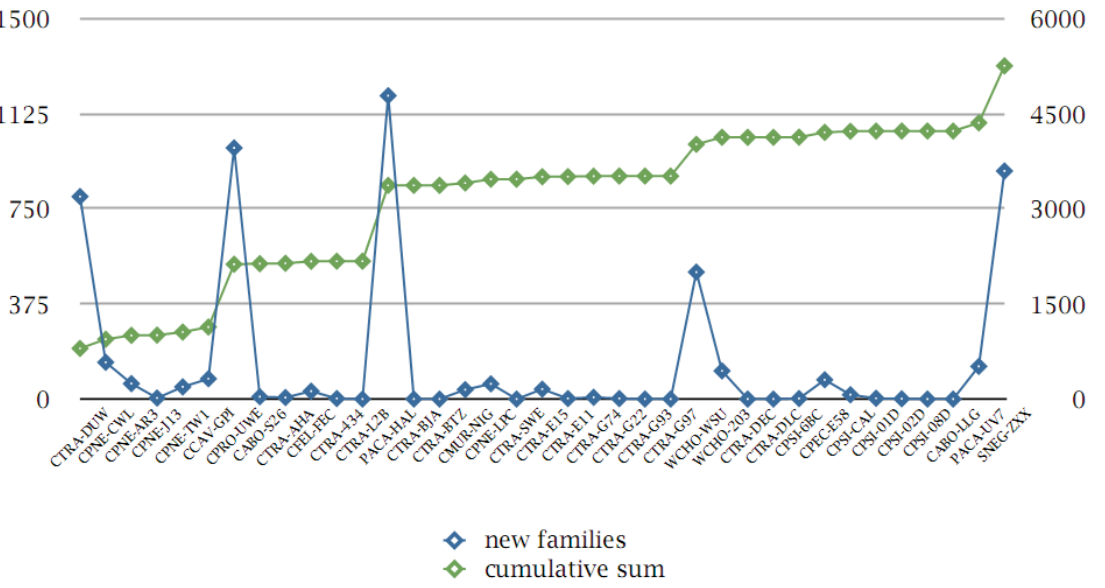
Figure 6. Protein family contributions from genome projects. Genome codes are sorted according to their original publication date (and/or release date, x-axis); absolute number of “novel” protein families within the pangenome are given (left y-axis, blue curve and square symbols); cumulative sum of protein families (up to 5,260, excluding those without self-hits, see text) is also shown, defined as a “pangenome saturation curve” (right y-axis, green curve and square